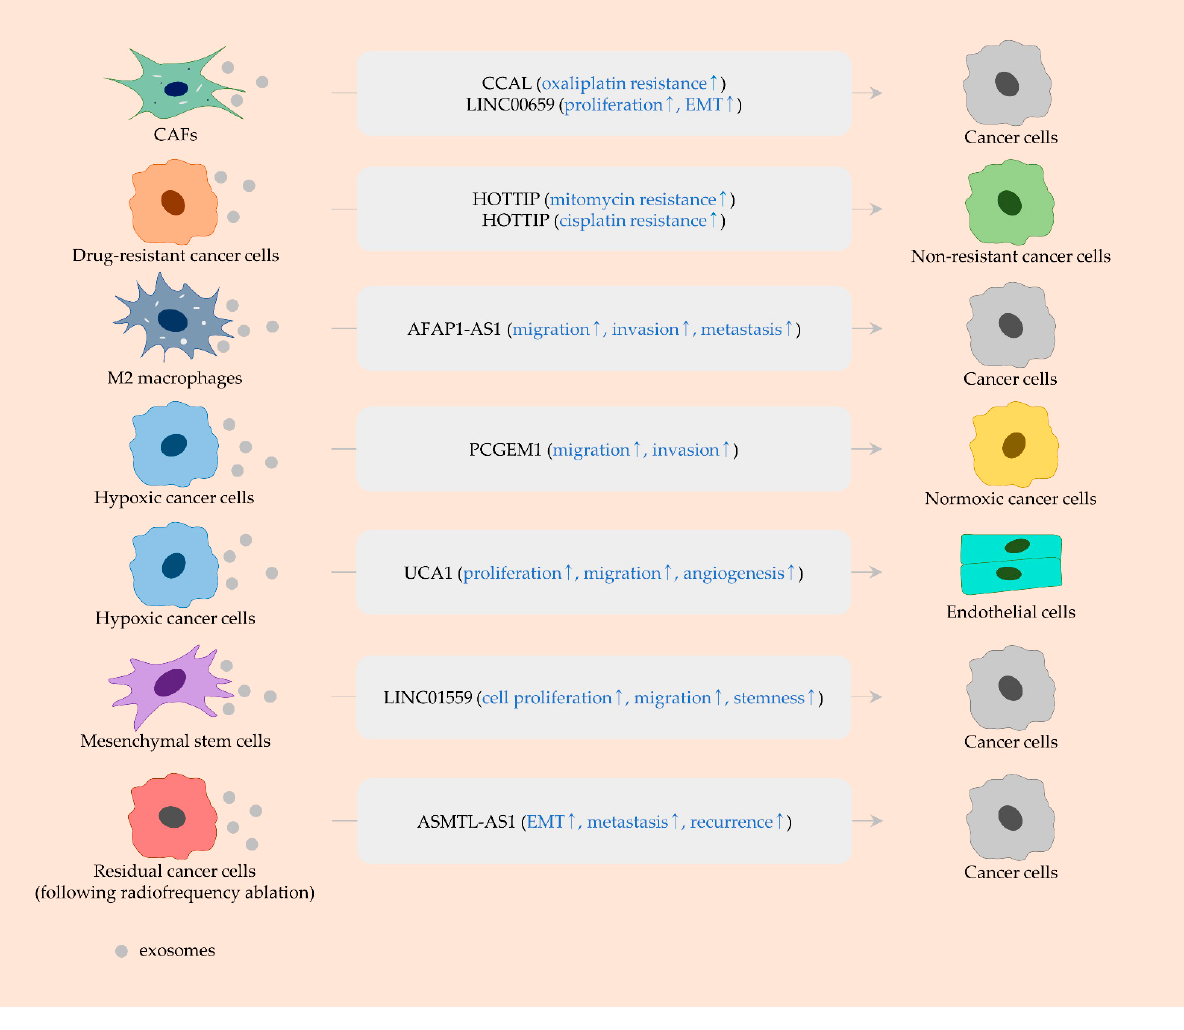
Figure 3. Exosomal lncRNAs derived from various cell types. LncRNAs (black), and their biological functions (blue) are indicated in rounded rectangles. An arrow ( ↑ ) indicates the upregulation. Table 2. Exosomal lncRNAs in gastrointestinal cancers (in alphanumerical order). Cargo Molecule